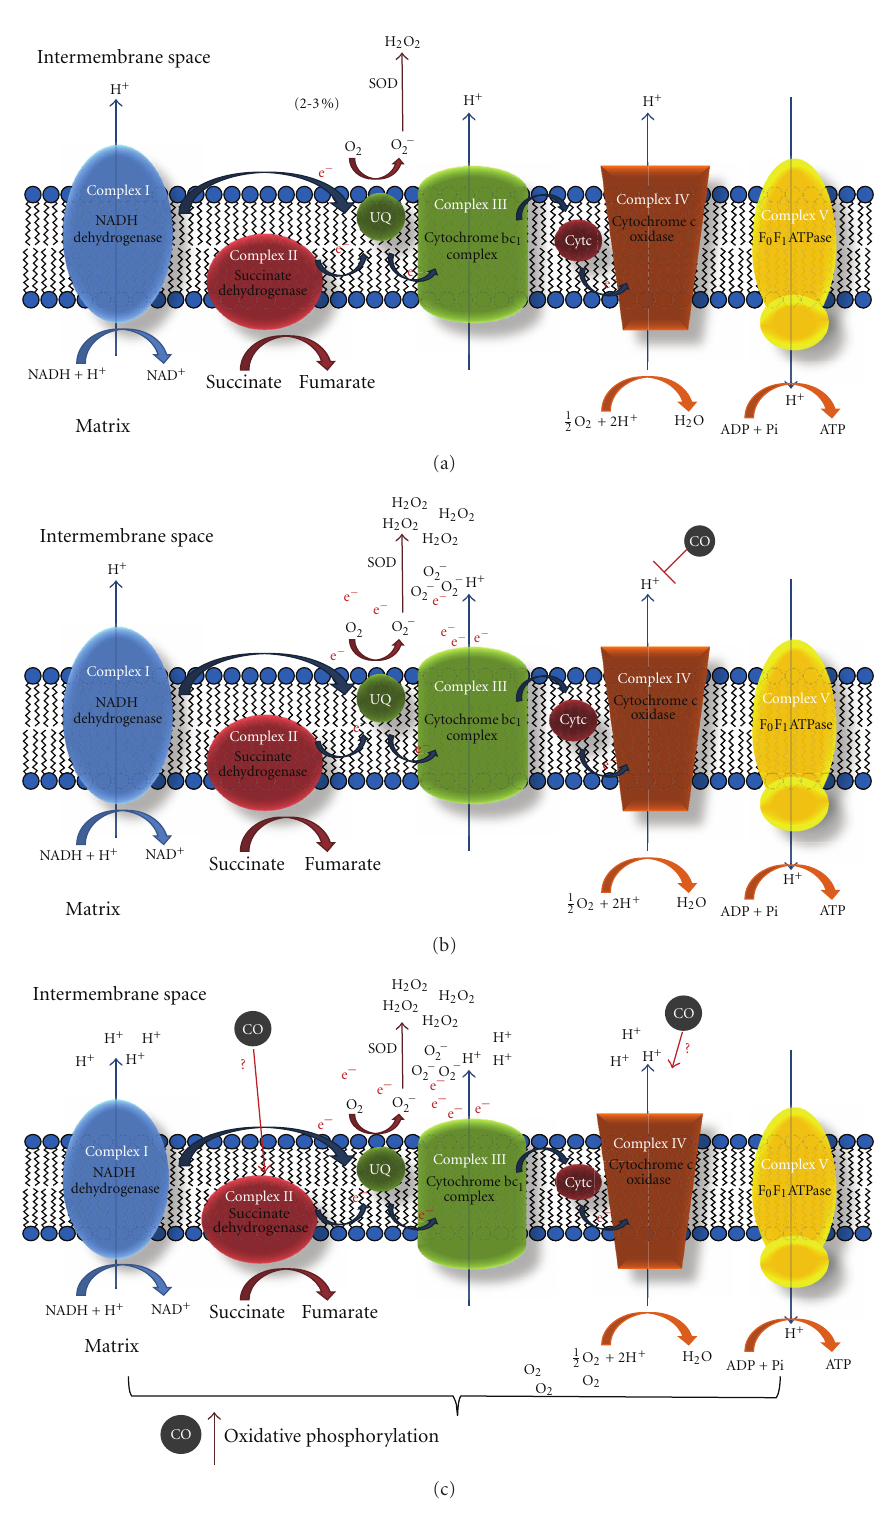
Figure 2: Proposed models for CO action on mitochondria. (a) Under physiological conditions, 1–3% of the consumed oxygen is incompletely reduced to anion superoxide (O 2 − ), which is rapidly converted into hydrogen peroxide (H 2 O 2 ) by the superoxide dismutase present in the mitochondrial matrix. (b) The most accepted hypothesis for CO to generate mitochondrial ROS is based on partially and/or reversely inhibition of cytochrome c oxidase (complex IV), leading to electron accumulation at complex III level, which facilitates anion superoxide generation. (c) Since low doses of CO also improve mitochondrial respiration, it can be speculated that CO induces mitochondrial ROS generation because oxidative phosphorylation is accelerated. The exact mitochondrial target is not fully understood, but complexes II and IV are strong